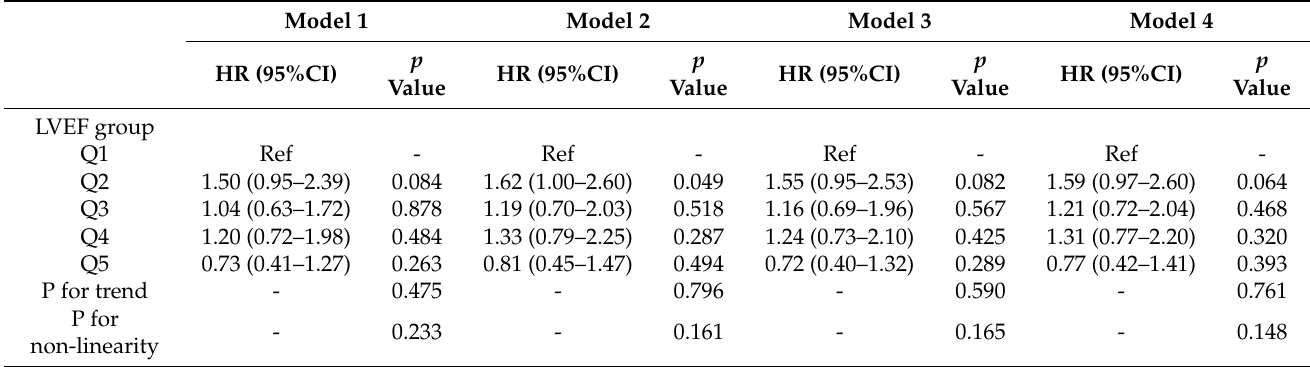
Table 4. Results of competing risk analysis for free from appropriate shock by LVEF quintiles.